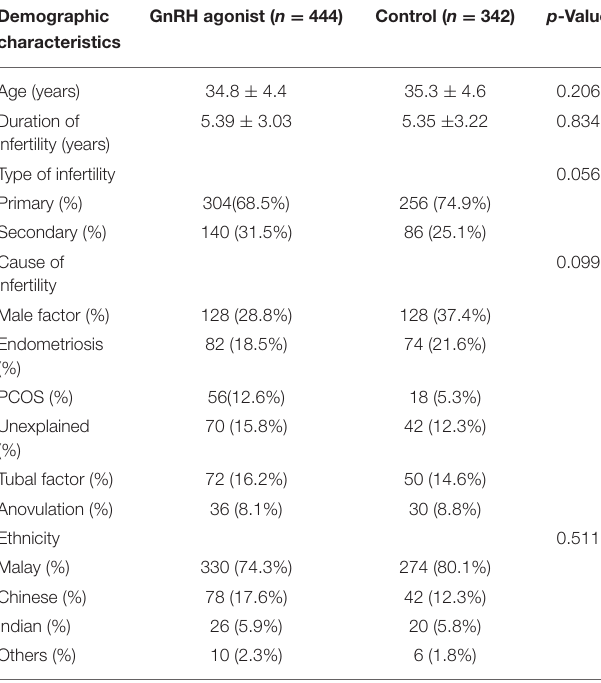
TABLE 3 | Comparison of pregnancy outcomes between GnRH agonist and control